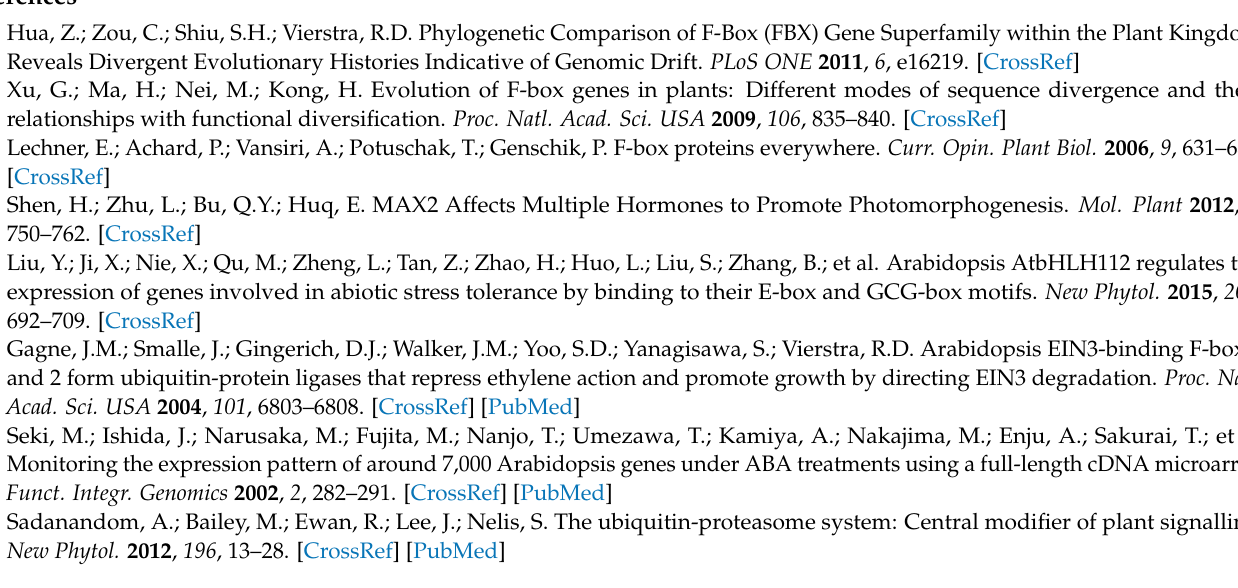
Table S2: Base information of SlFBX gene family; Table S3: Cis-elements